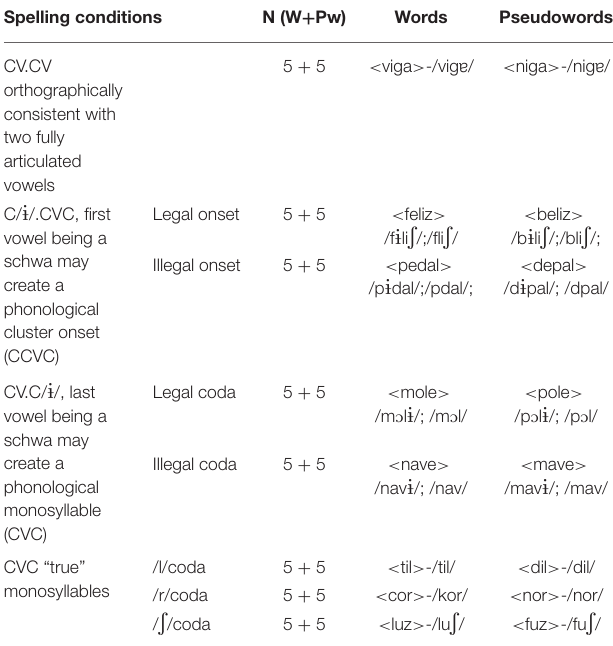
TABLE 1 | Spelling conditions and examples of words and pseudowords used in spelling